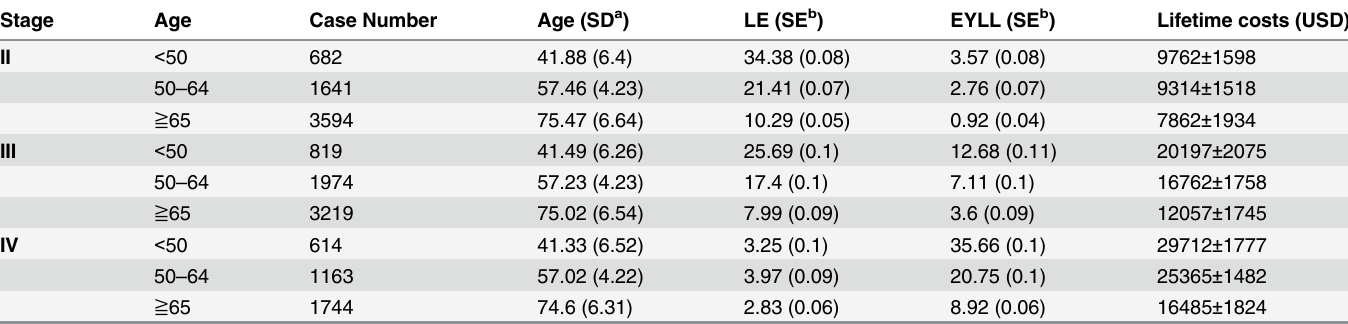
Table 3. The life expectancy (LE), expected years of life lost (EYLL), and lifetime costs of colon adenocarcinoma by stage and ages. Stage